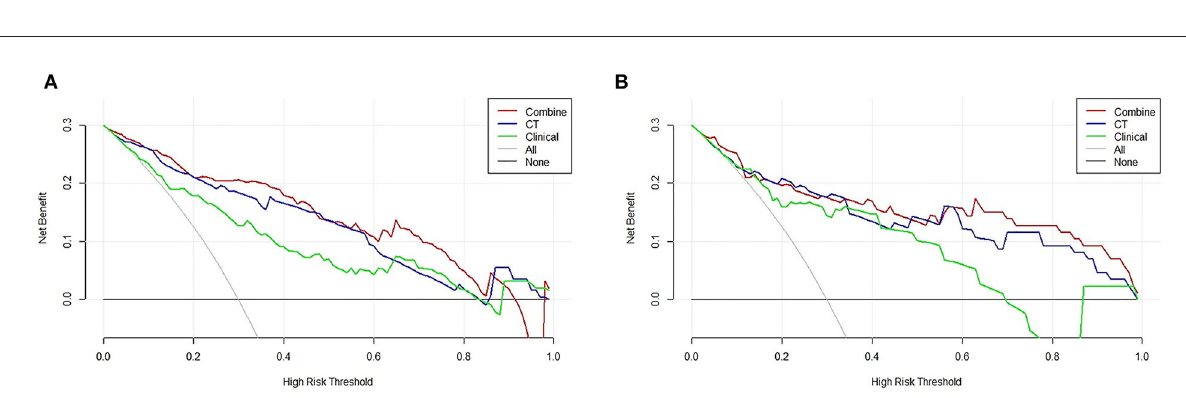
FIGURE7 Decision curve analysis (DCA) of the combined model, clinical model, and computed tomography (CT) model. Evaluation in (A) the training cohort and (B) the validation cohort. y -axis: net benefit; x -axis: threshold probability. The combined model (red line) obtained the highest net benefit compared with the CT model (blue line), the clinical model (green line), the intervention-all strategy (gray line), and the intervention-none strategy (horizontal black